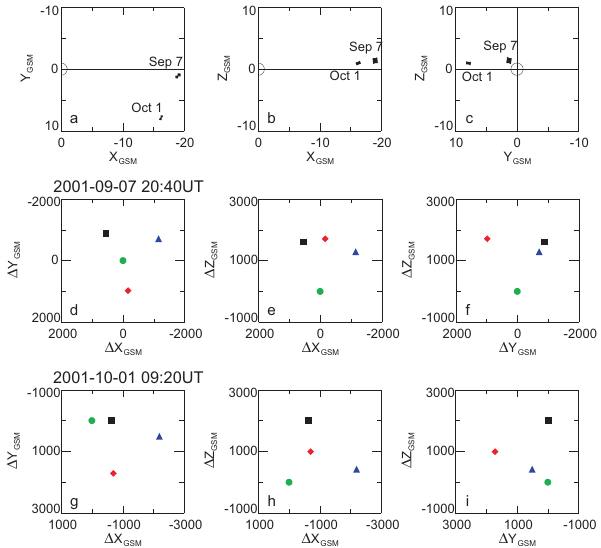
Fig. 7. Cluster location for the 7 September and 1 October events and tetrahedron configuration for 7 September and 1 October event.